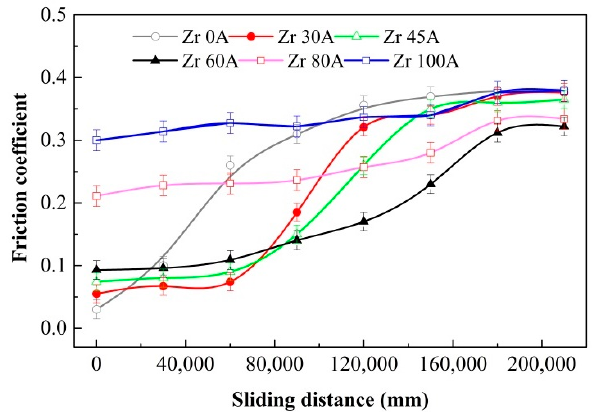
Figure 13. E ff ect of Zr current on the average friction coe ffi cient of coatings (sliding speed 260 mm / s, Figure 13. Effect of Zr current on the average friction coefficient of coatings (sliding speed 260 mm/s, applied load 10 applied load 10 N).